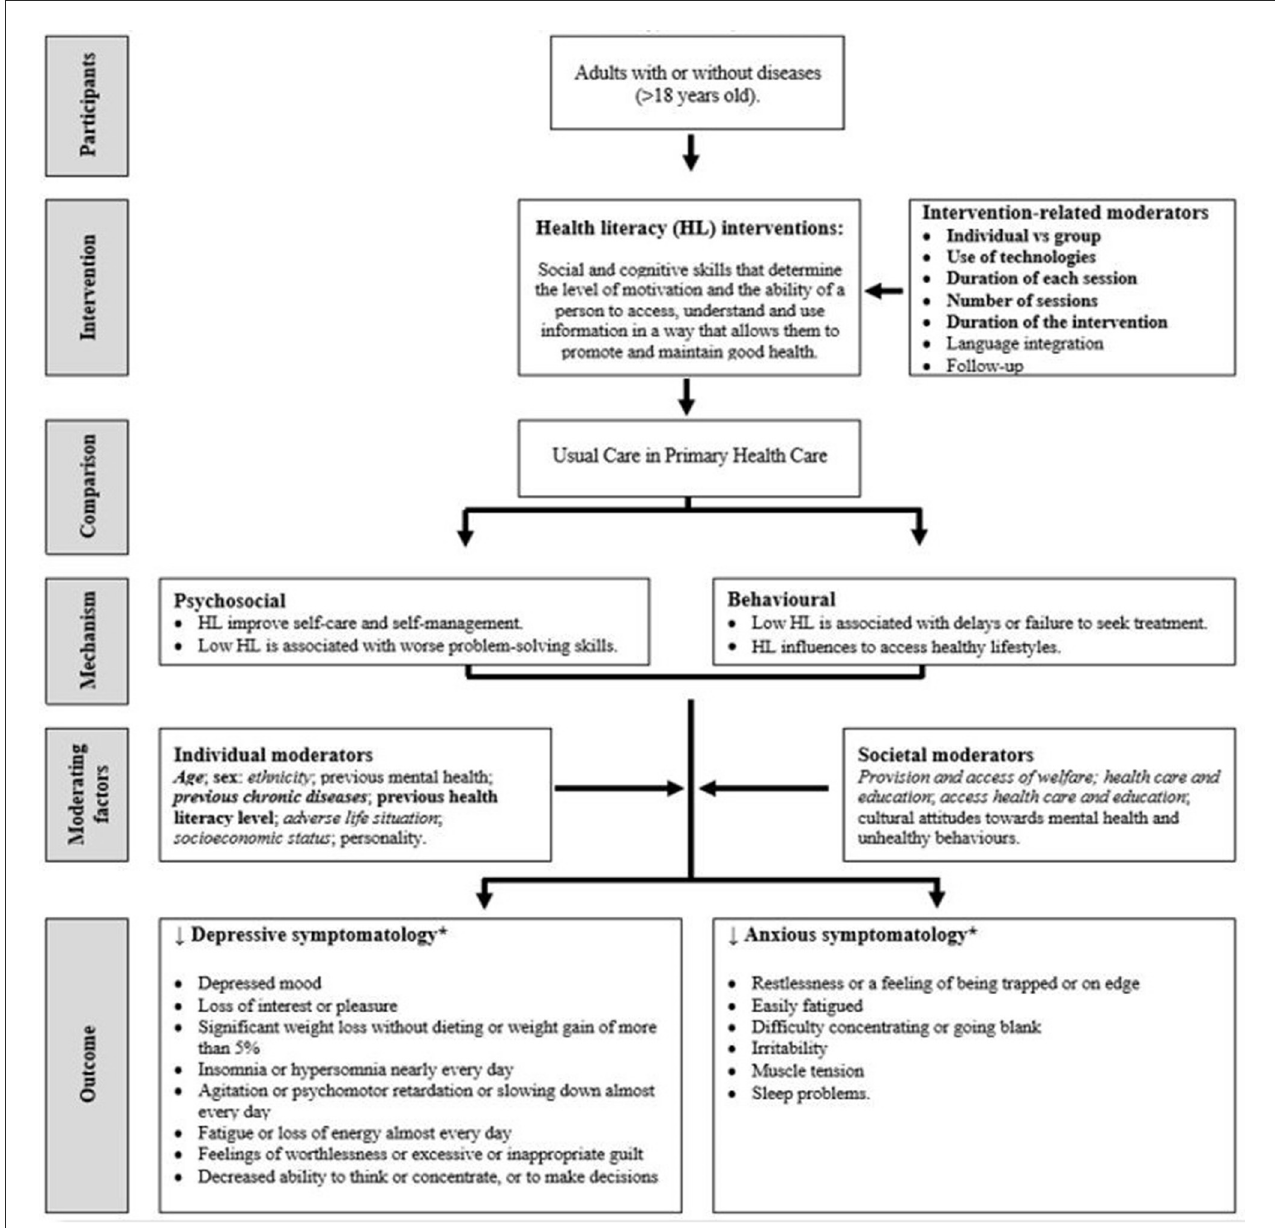
FIGURE1 Conceptual model indicating theory of change for health literacy and mental health. * Measured with validated with validated scales. Health literacy descripted following the model concept an definitions by Sorensen et al. (15); depressive and anxious symptomatology descripted following the definitions included in the DSM-V (38). Variables considered as important potential confounders in this study are indicated in italics and were selected a priori by the researchers based on variables that were viewed as key confounders in the literature. Variables considered important potential effect modifiers for exploration in this study are indicated in bold; these were selected based on assumptions regarding their likely importance and anticipated data